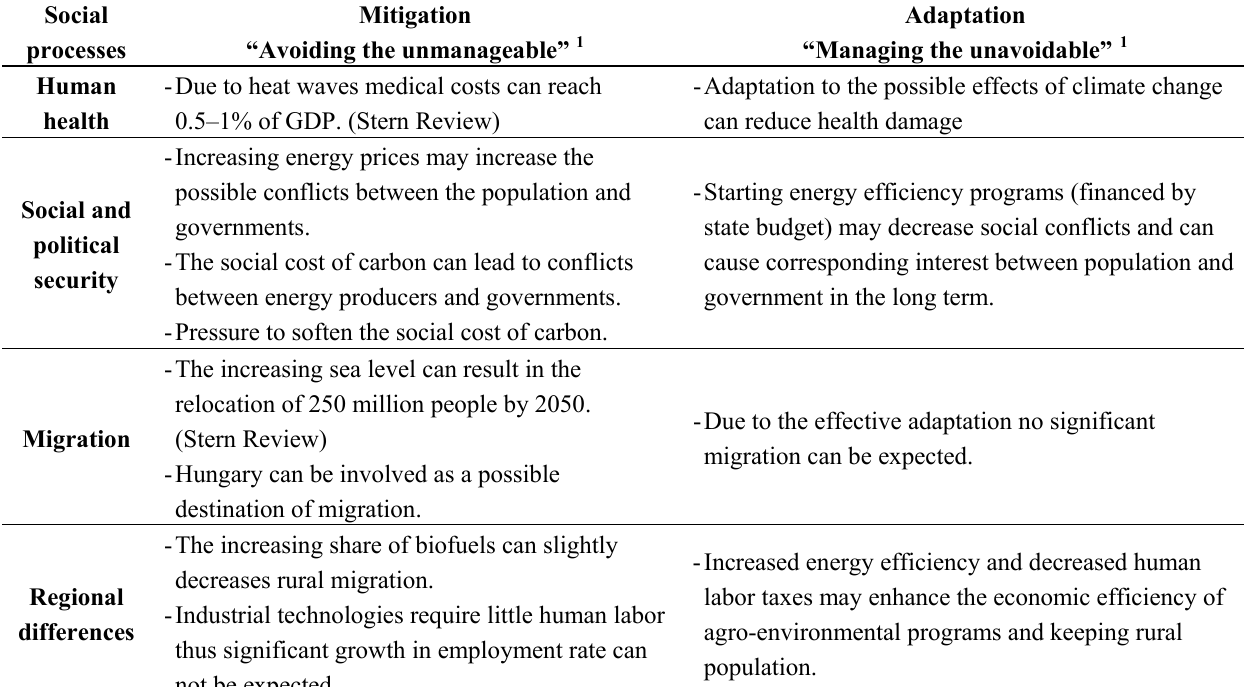
Table 5. Social effects of GHG emission reduction and adaptation measures (Source: own